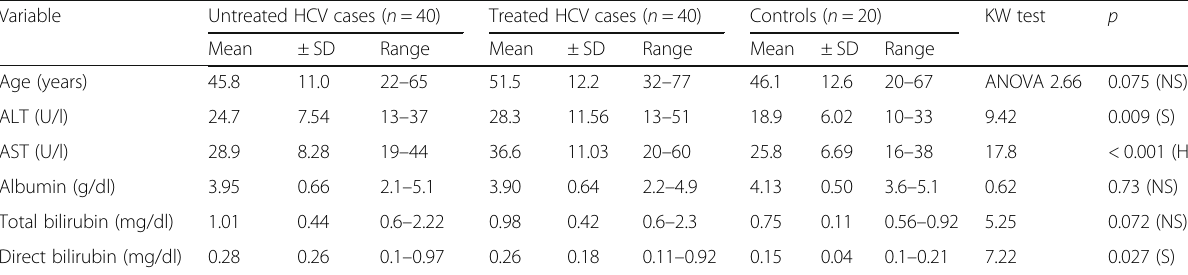
Table 1 Comparing the studied groups regarding liver function tests